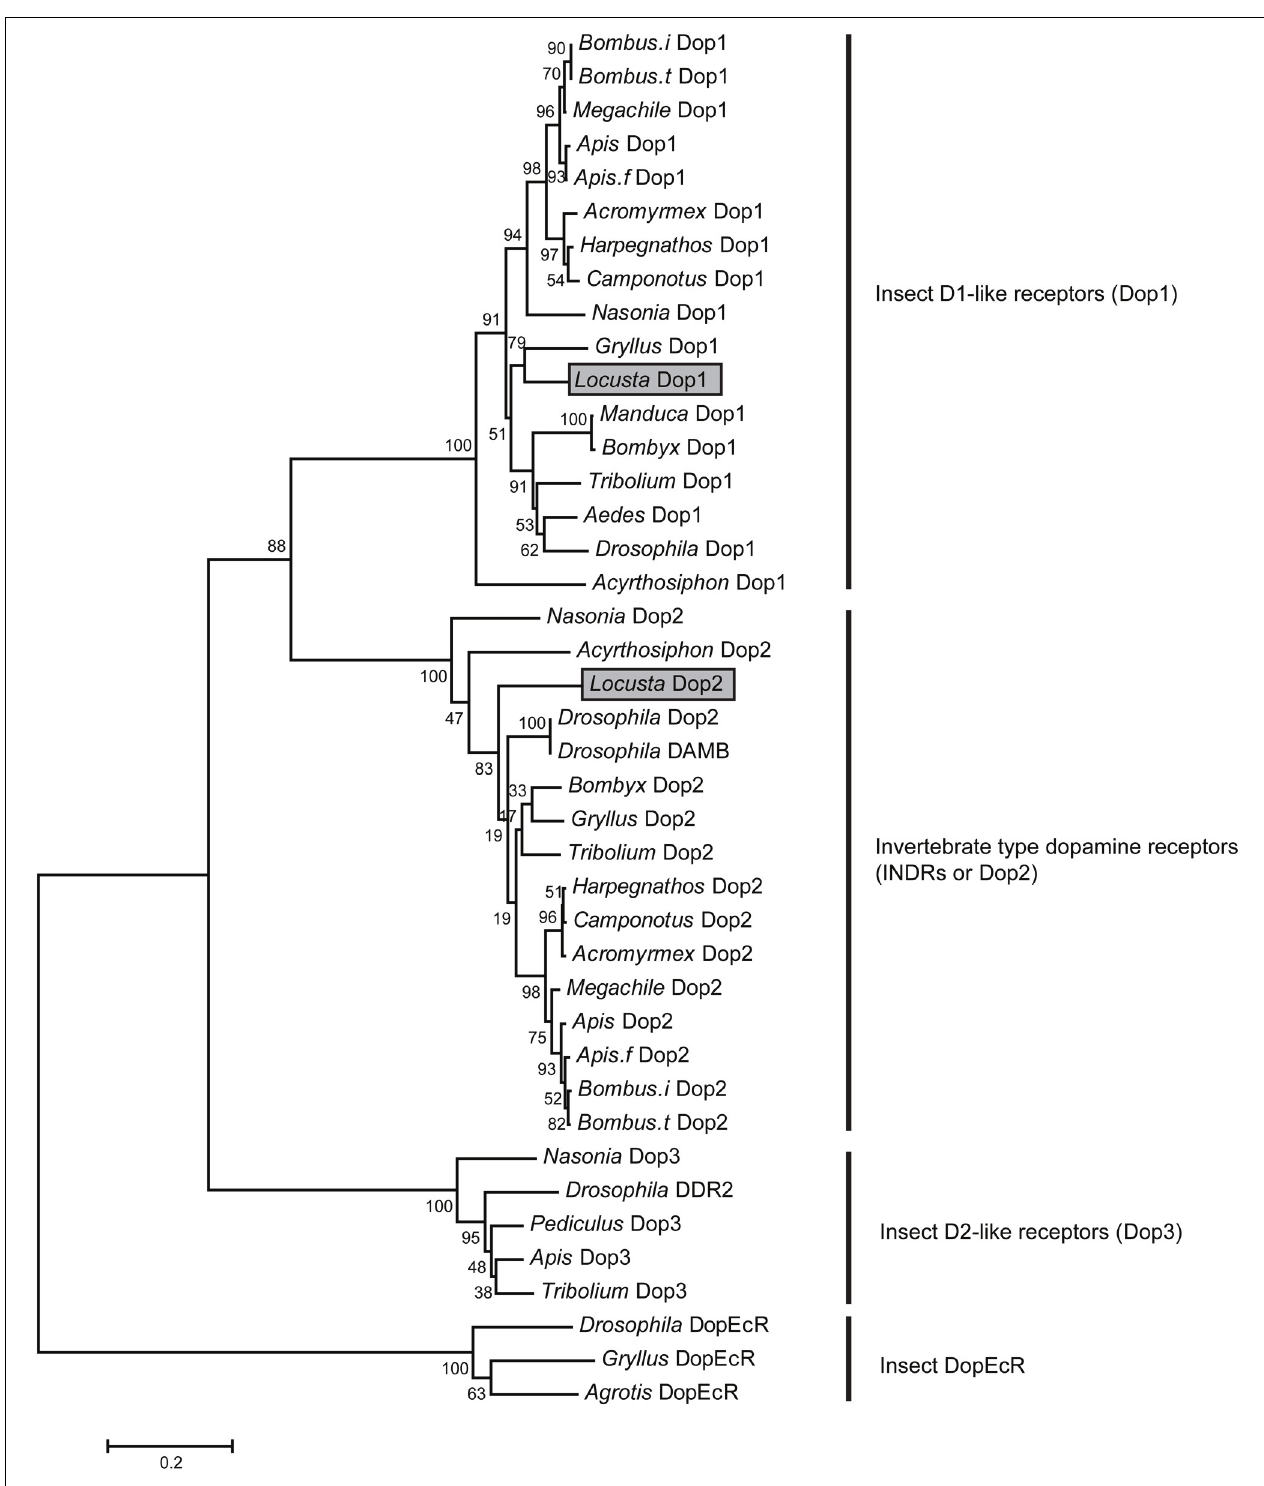
Bombus impatiens; Bombus.t, Bombus terrestris; Bombyx, Bombyx mori; Camponotus, Camponotus floridanus; Drosophila, Drosophila melanogaster; Harpegnathos, Harpegnathos saltator; Gryllus, Gryllus bimaculatus; Locusta, Locusta migratoria; Manduca, Manduca sexta; Megachile, Megachile rotundata; Nasonia, Nasonia vitripennis; Pediculus, Pediculus humanus corporis; Tribolium, Tribolium castaneum.